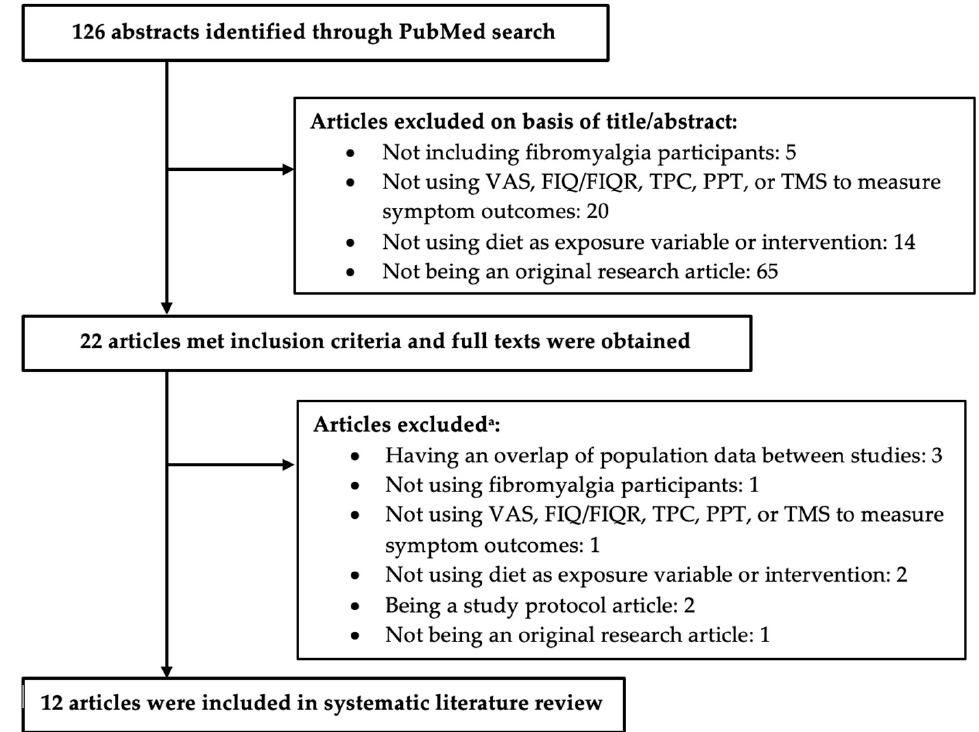
Figure 1. Flow chart of the systematic literature review. Abbreviations used: visual analogue scale for pain (VAS), fibromyalgia impact questionnaire/revised fibromyalgia impact questionnaire (FIQ/FIQR), tender point count (TPC), pain pressure threshold (PPT), or total myalgic score (TMS).